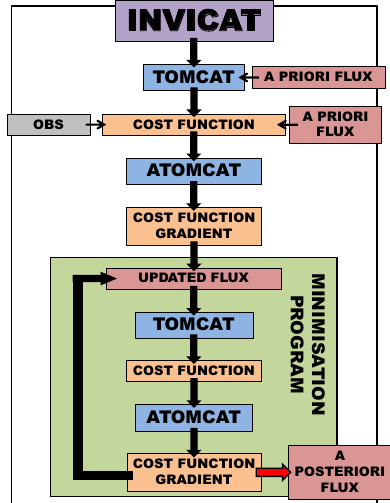
Figure 7. Flowchart depicting the individual steps taken by the Fig.7. Flowchart depicting theindividual stepstakenby theINVICAT4D-Varinversemodel. TOMCAT INVICAT 4D-Var inverse model. TOMCAT and ATOMCAT are and ATOMCAT are shown in blue, cost function evaluation programs are orange, flux estimates are red and observations are grey. The green section is repeated iteratively until some convergence criteria is shown in blue, cost function evaluation programs are orange, flux met, when the a posteriori flux estimate is evaluated. estimates are red and observations are grey. The green section is re- peated iteratively until some convergence criterion is met, when the a posteriori flux estimate is